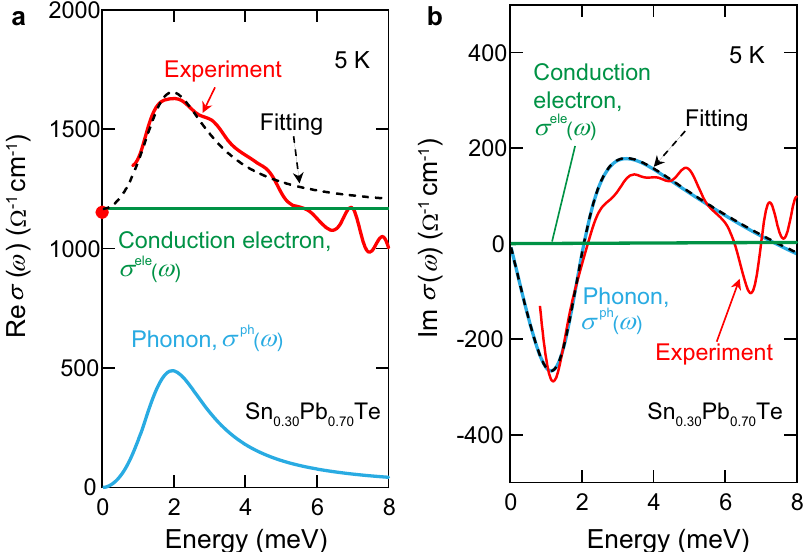
Fig. 3 Decomposition of the terahertz conductivity spectra into the electronic and phonon responses. Real ( a ) and imaginary ( b ) parts of σ ( ω ) at 5 K for Sn 0.30 Pb 0.70 Te. Red solid, green solid, light blue solid and black dashed curves represent the experimental spectrum, electronic continuum band σ ele ( ω ), phonon response σ ph ( ω ) and fi tting spectrum, respectively. The red fi lled circle at zero energy at ( a ) denotes the DC conductivity obtained from the transport